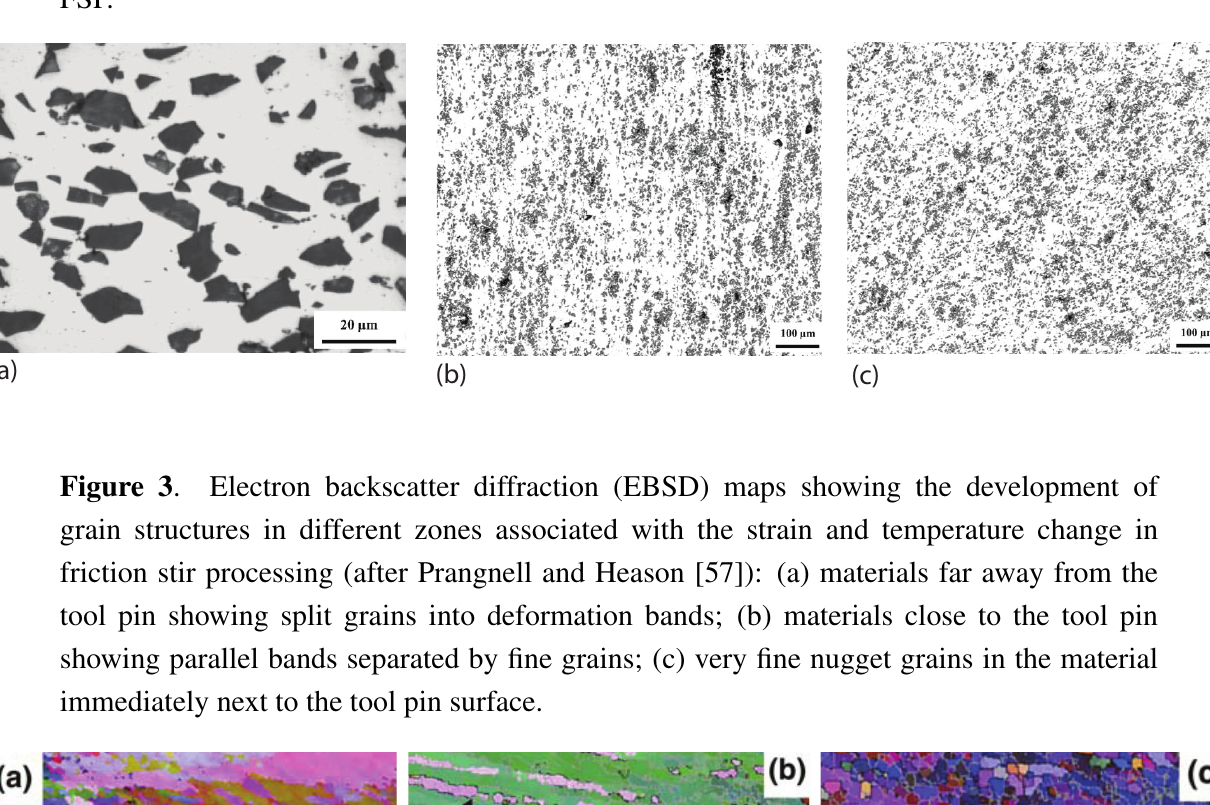
Figure 2 . Microstructure change in SiC particle reinforced A6061 due to friction stir processing (after Tewari et al. [53]): (a) scanning electron microscopic image of the composite showing the anisotropic shape of SiC particles; (b) as-extruded SiC/Al; (c) after FSP.